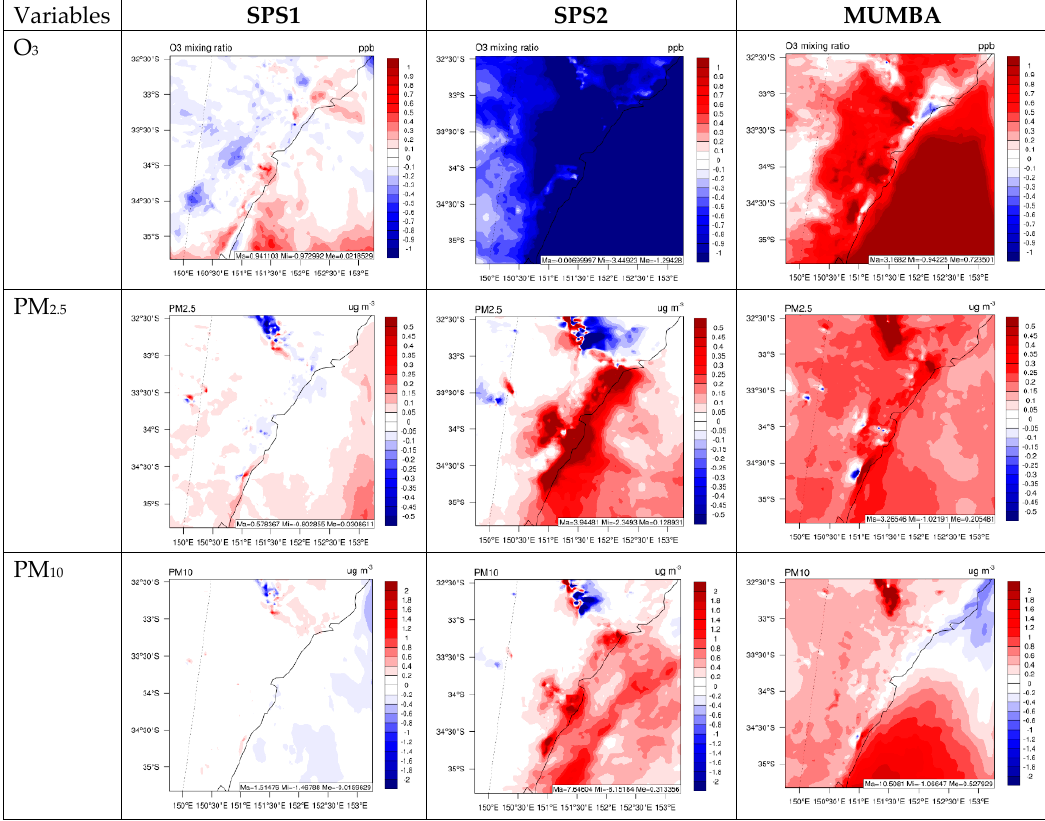
Figure 10. Differences in simulated O 3 , PM 2.5 , and PM 10 between WRF/Chem-ROMS and WRF/Chem-NCSU over Greater Sydney Figure 10. Di ff erences in simulated O 3 , PM 2.5 , and PM 10 between WRF / Chem-ROMS and (d04). WRF / Chem-NCSU over Greater Sydney